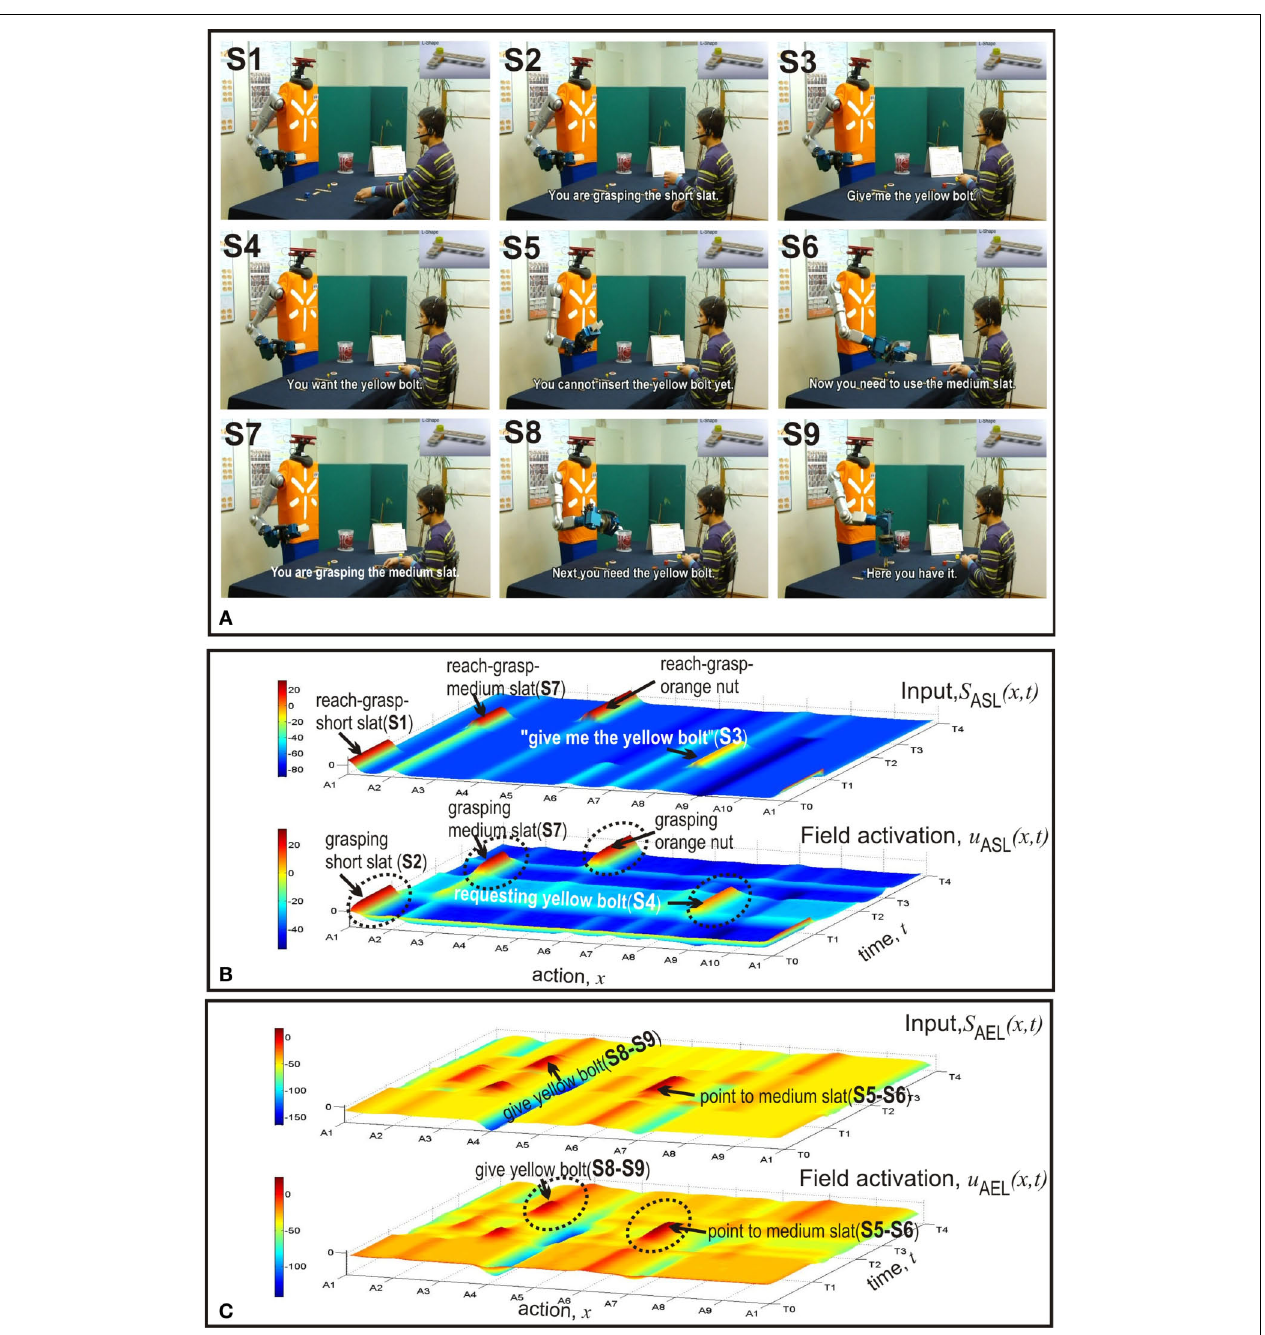
FIGURE 7 | Third example: Error detection and correction. (A) Video snapshots. (B) Temporal evolutions of input to ASL (top) and activity in ASL (bottom). (C) Temporal evolutions of input to AEL (top) and activity in AEL